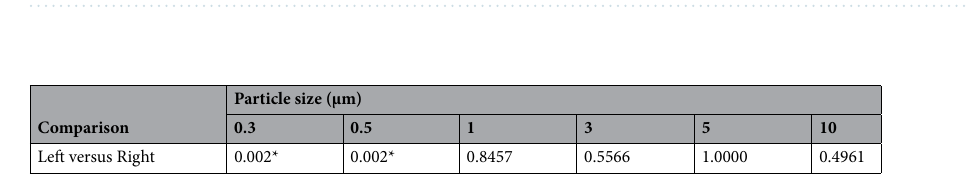
Table 4. P values for comparisons between left versus right side of toilet at Height 0.15 m and Position 4, n = 10. *= statistical significance with a 0.05 threshold.